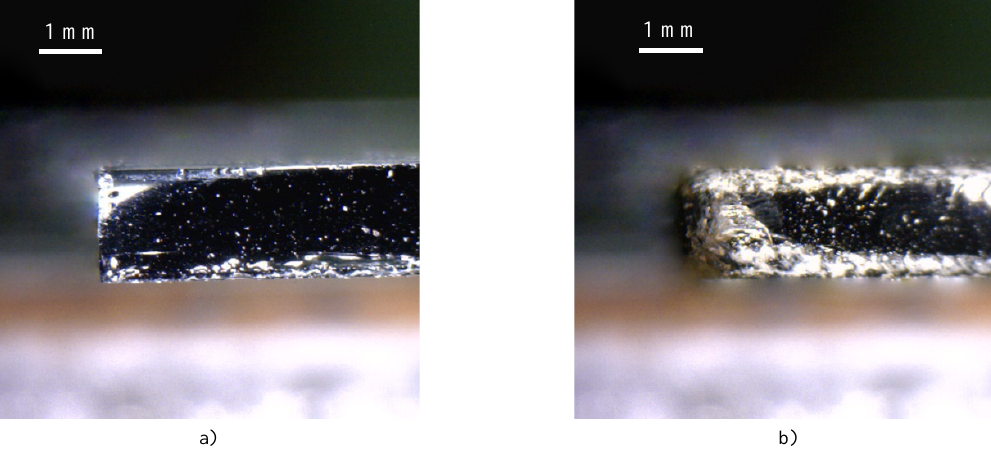
Fig. 1 Microscope pictures of specimen’s edge: cut edge a) and ground edge